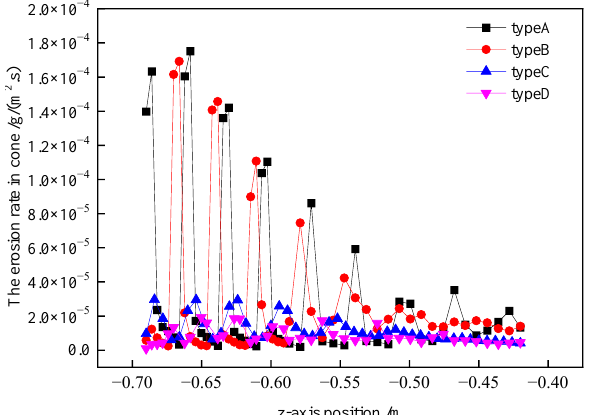
Figure 19. Cone erosion rate varied with different vortex finders.